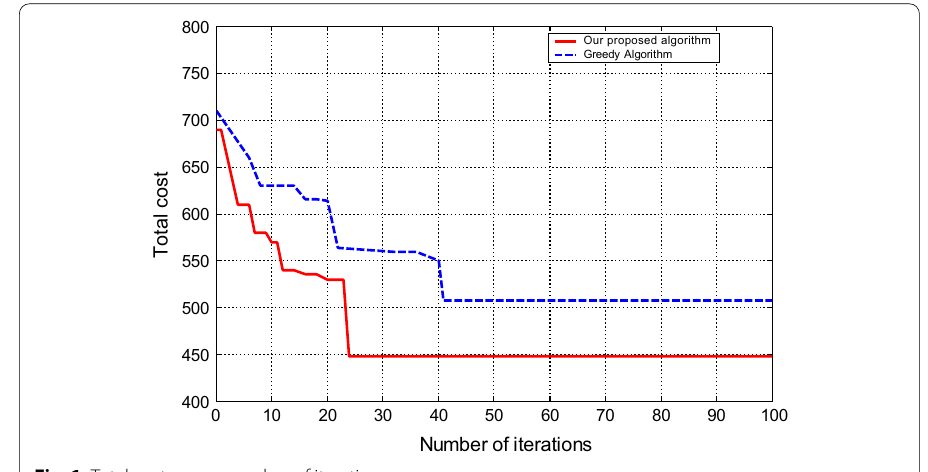
Fig. 1 Total cost versus number of iterations